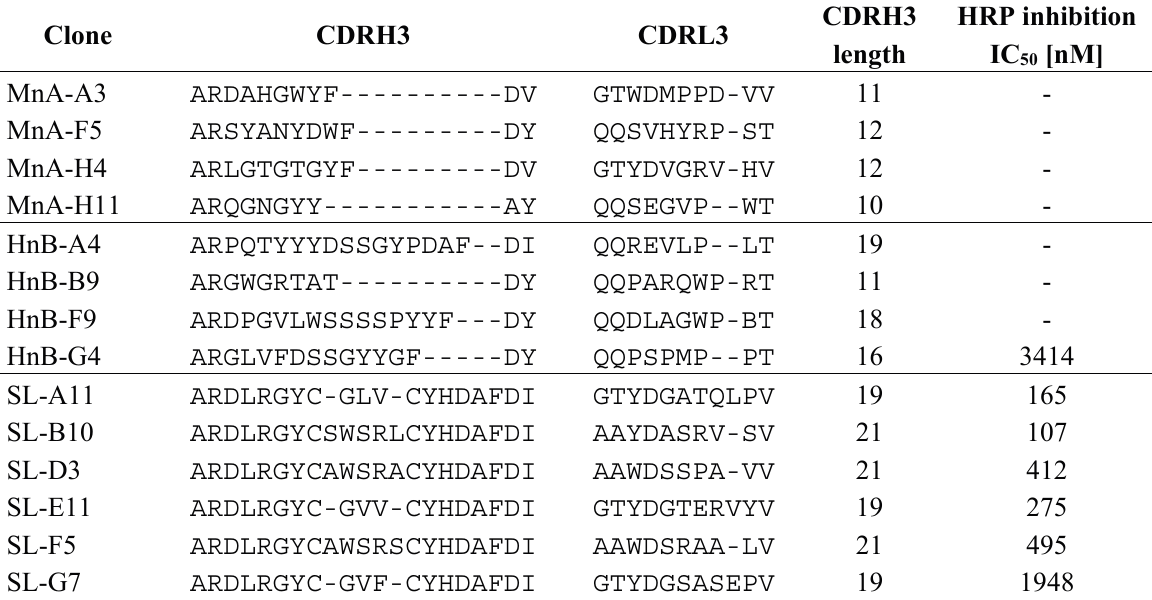
Table 2. Characteristics of clones directed against HRP. HRP inhibition was assessed by enzyme-linked immunosorbent assay; -, no